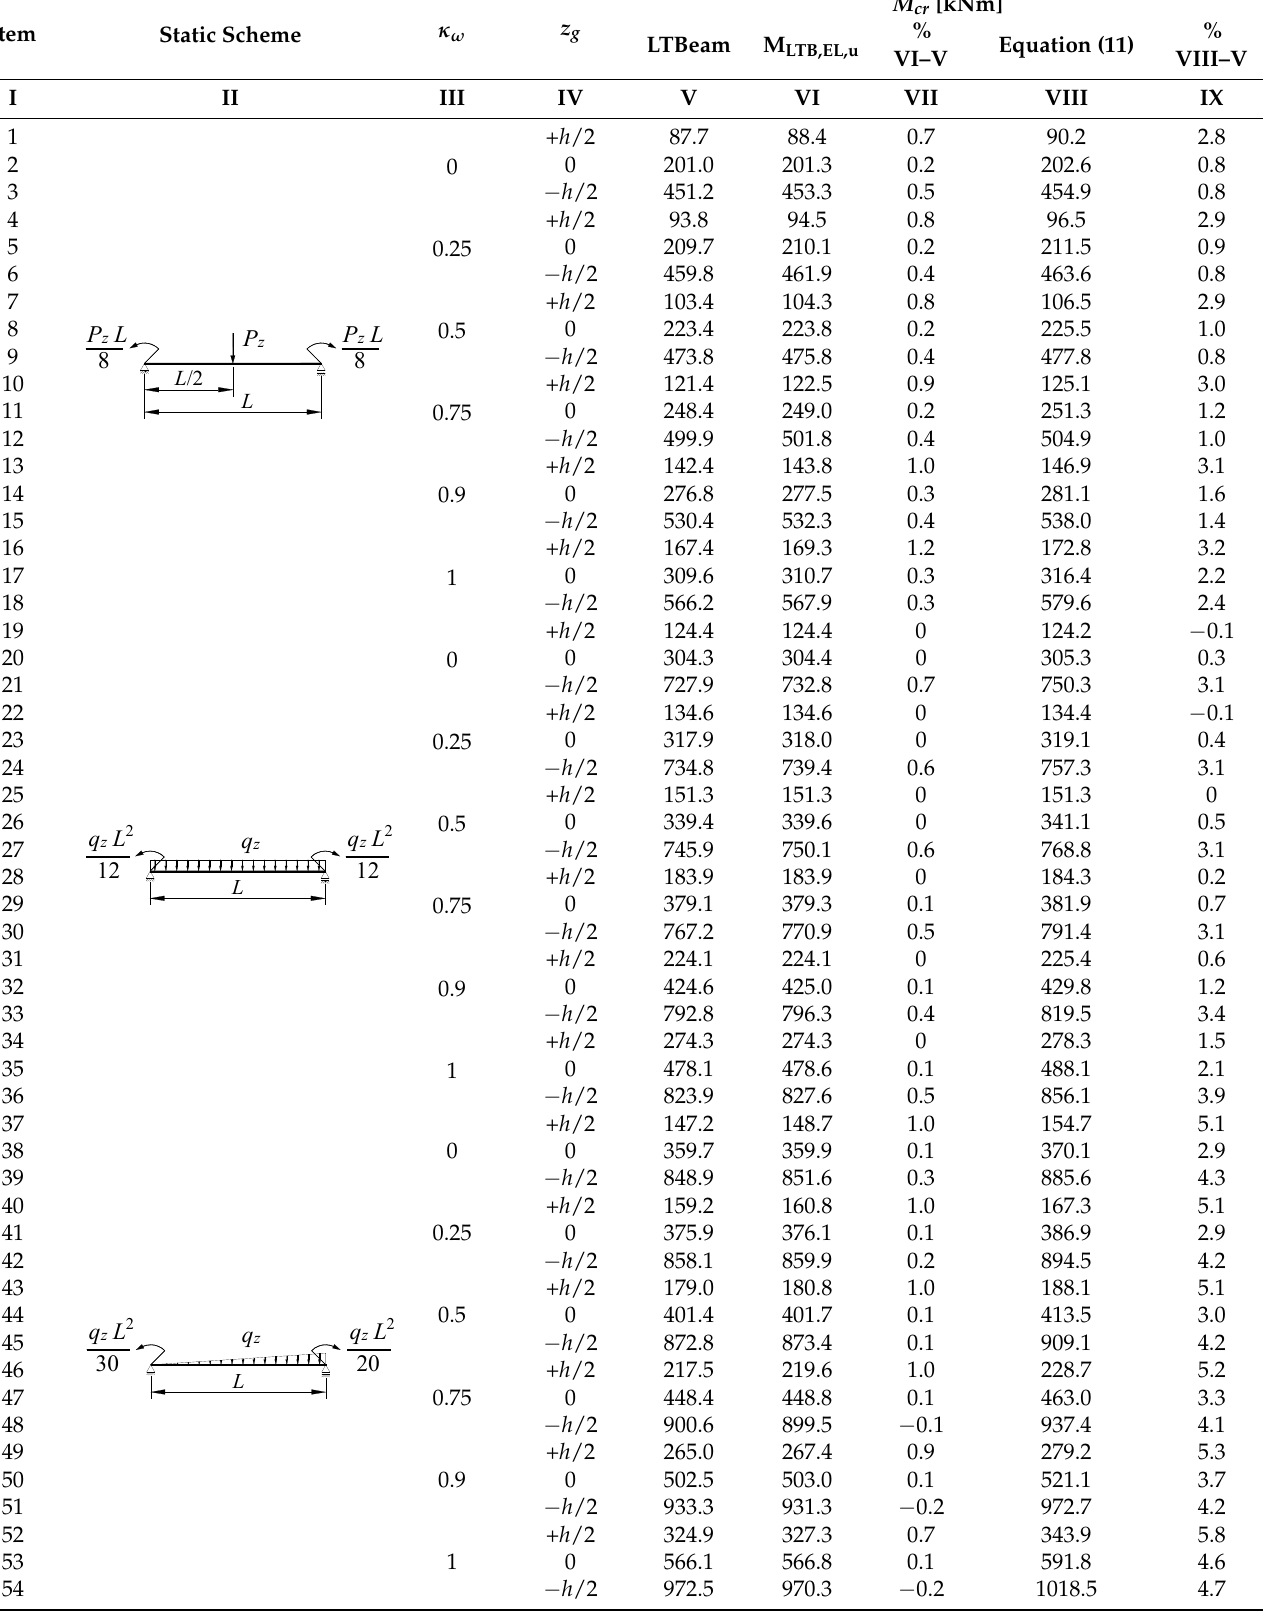
Table 5. Comparison of M cr,u for an IPE300 beam ( L = 5 m) elastically restrained against warping. Item